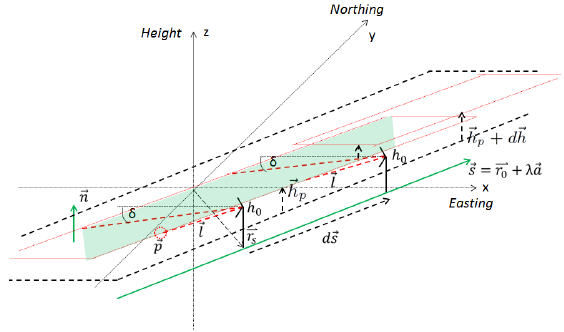
Figure 1: Street mapping geometry for each synthetic aperture d(cid:126)s . The radar sensor is mounted h 0 = 2 m above the street level with an depression angle δ of 30 degrees. In steps of the length of one synthetic aperture the height of the focusing plane is adjusted by the height distance d(cid:126)h calculated from the INS